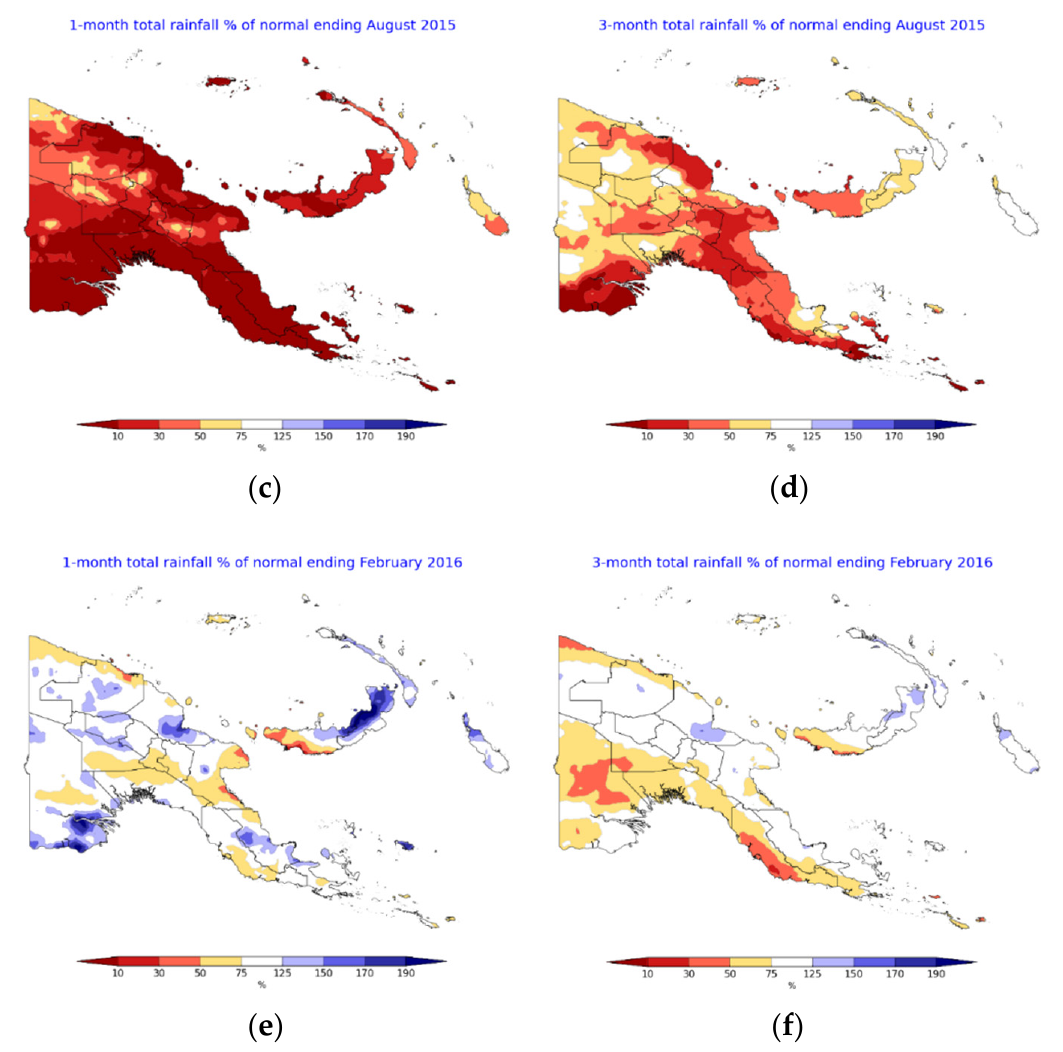
Figure 8. One-month and 3-month rainfall percentages of normal depicting onset of meteorological drought conditions in June 2015 and easing in February 2016. ( a ) 1-month onset; ( b ) 3-month onset; ( c ) 1-month peak; ( d ) 3-month peak; ( e ) 1-month cessation; ( f ) 3-month cessation.